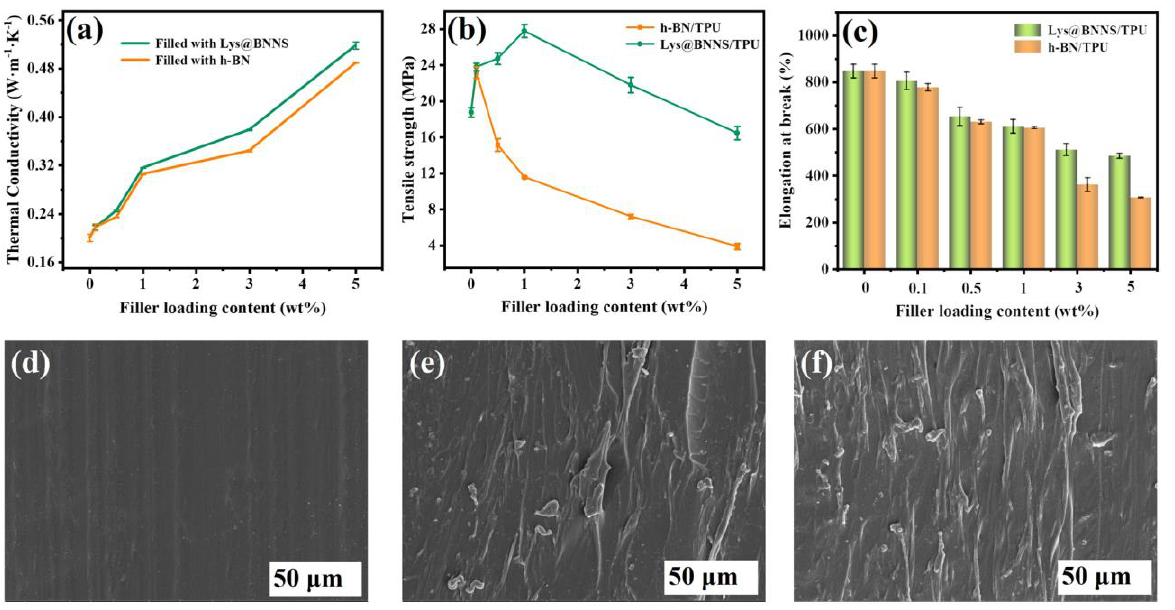
Figure 5. ( a ) Thermal conductivity, ( b ) tensile strength, and ( c ) elongation at break of composites as a function of filler content. SEM images of ( d ) TPU, ( e ) 0.1 wt% h-BN/TPU, and ( f ) 0.1 wt%